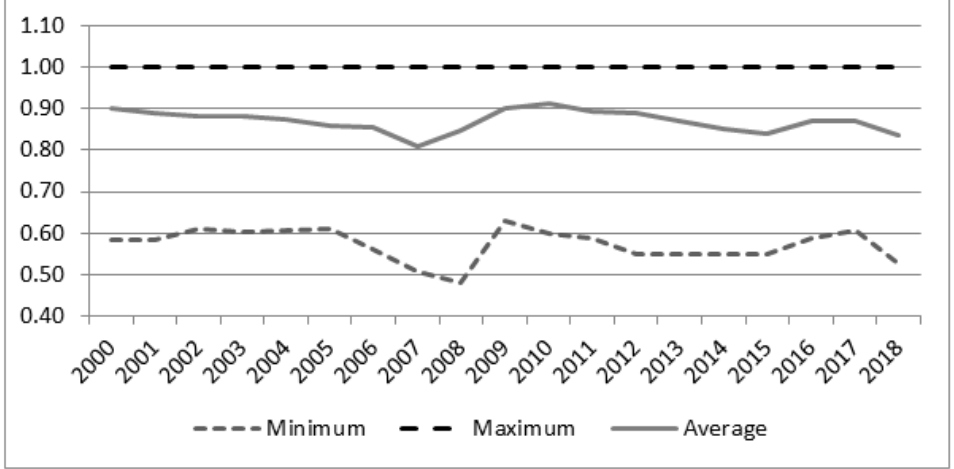
Figure 1. Development of the average BCC-DEA environmentally sensitive efficiency scores for Model 2 in the period 2000–2018 .